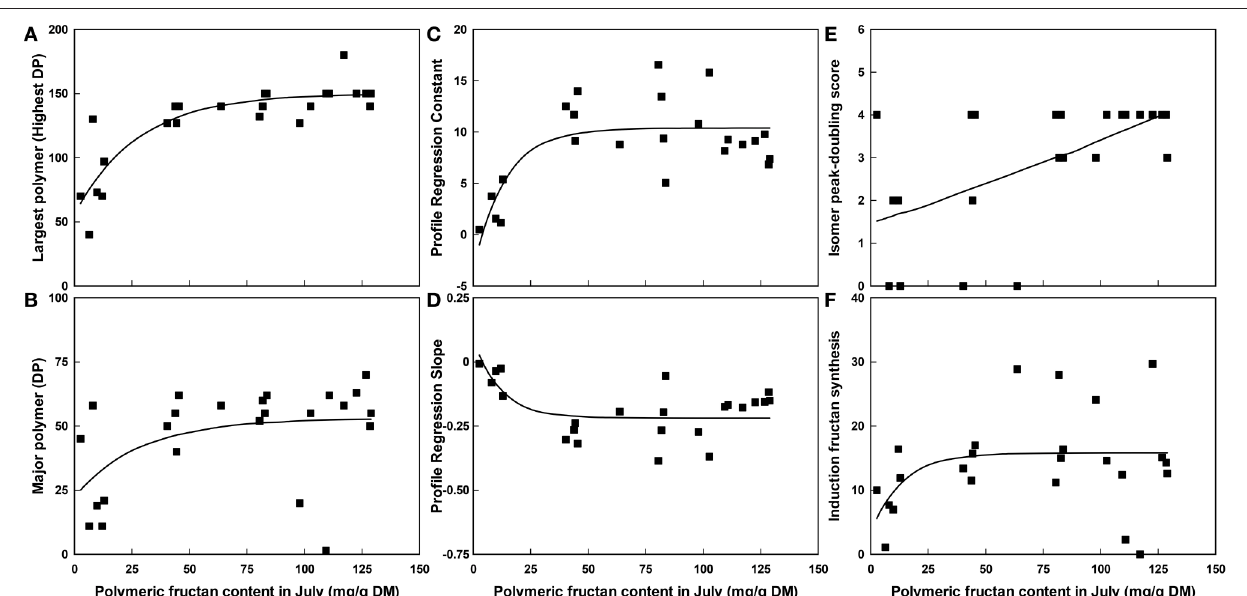
FIGURE 2 | The relationship between polymeric fructan content (mg/g DM) in July when carbohydrate content was high and selected polymer traits across all plants from the GRASP and the WSC F2 mapping family subsets combined, n = 24 . (A) The largest polymer present, (B) The major polymer present, (C) The constant of the profile regression, (D) The slope of the profile regression, (E) The isomer peak-doubling score and (F) Fructan synthesis during induction. Lines fitted by regression using an exponential